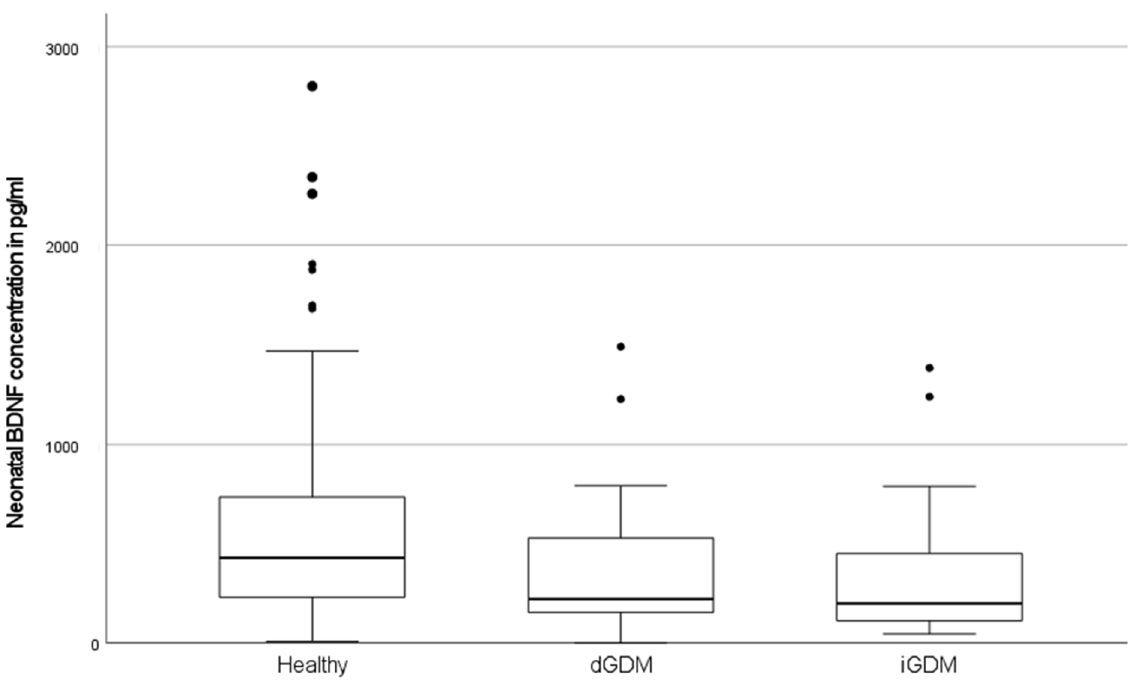
Figure 2. BDNF concentration (pg/mL) in neonates of mothers with dietary (dGDM), insulin-de- pendent gestational diabetes (iGDM) and metabolically healthy